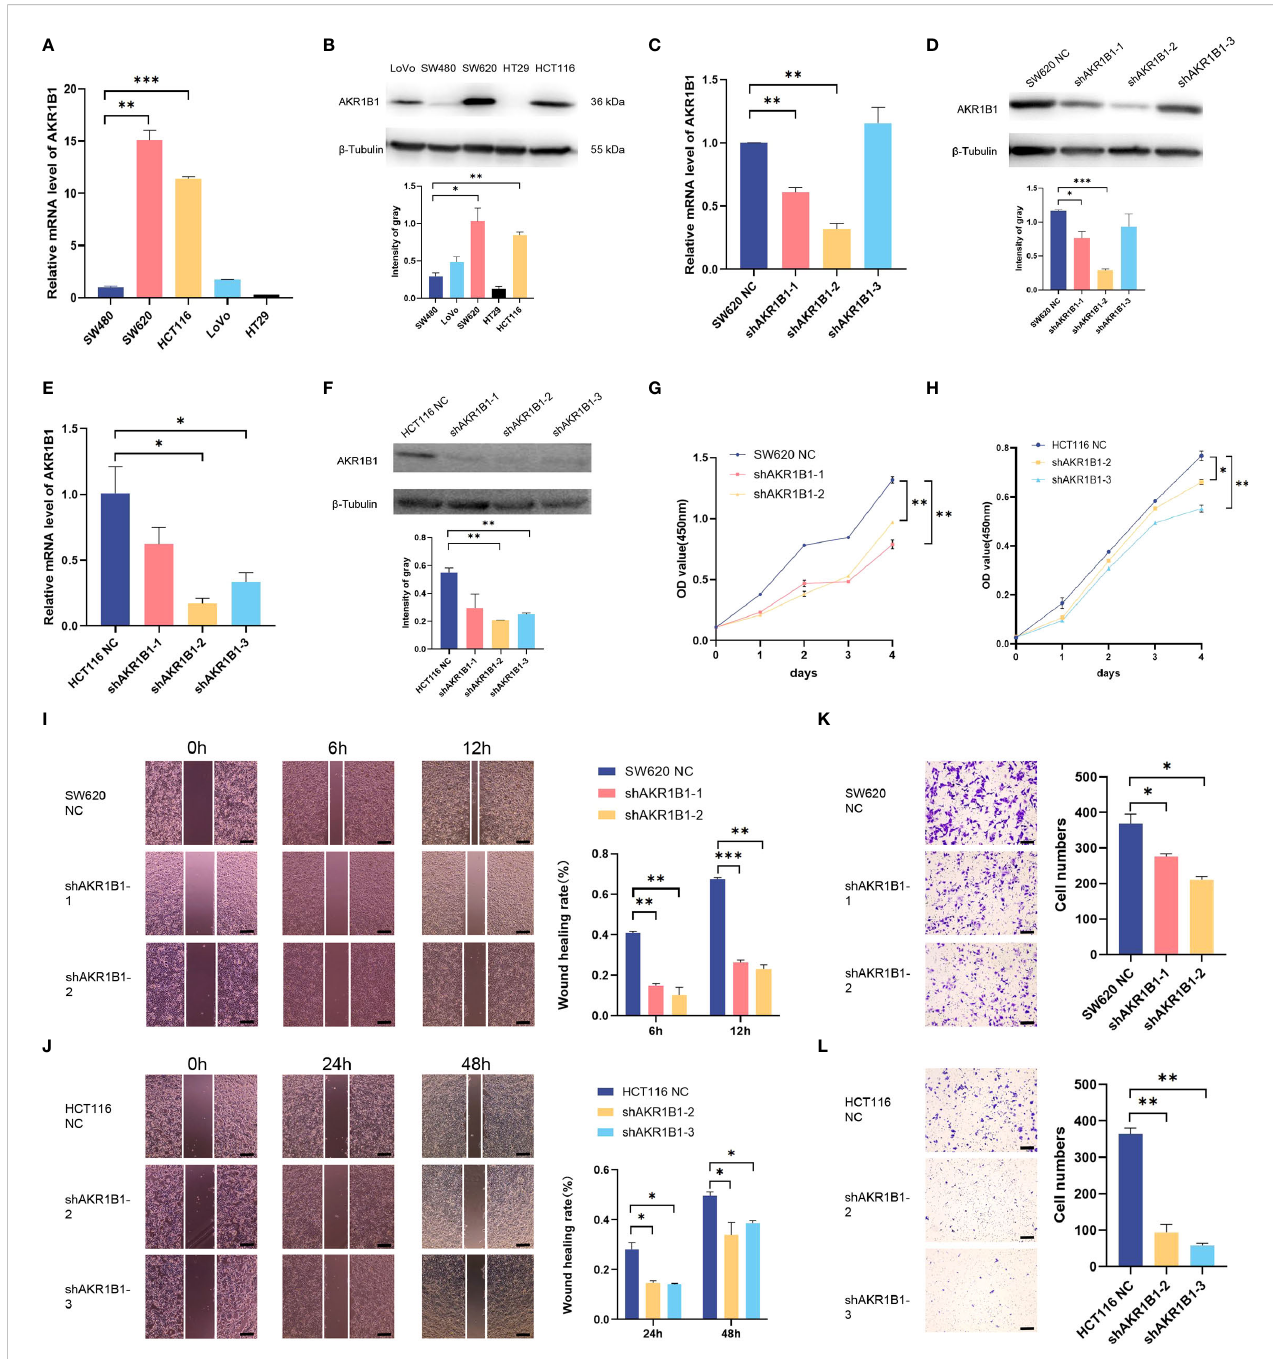
FIGURE 6 Knockdown of AKR1B1 inhibited cell proliferation, migration, and invasion. (A, B) The transcriptional level (A) and protein level (B) of AKR1B1 were detected in multiple colorectal cancer cell lines (SW480, SW620, HCT116, LoVo, and HT29) using RT-PCR and WB. (C, D) The transcriptional level (C) and protein level (D) of AKR1B1 were detected in the control and knockdown groups of SW620 using RT-PCR and WB. (E, F) The transcriptional level (E) and protein level (F) of AKR1B1 were detected in the control and knockdown groups of HCT116 using RT-PCR and WB. (G, H) Cell proliferation of SW620 (G) and HCT116 (H) in control and knockdown groups was detected using CCK8 assay. (I, J) Cell migration of SW620 (I) and HCT116 (J) in control and knockdown groups was detected using wound healing assay. (K, L) Cell invasion of SW620 (K) and HCT116 (L) in control and knockdown groups was detected using transwell assay. The scale bars on the lower right in (I – L) are 200 µm. *P < 0.05, **P < 0.01 and ***P < 0.001. NS, not signi fi cant difference.